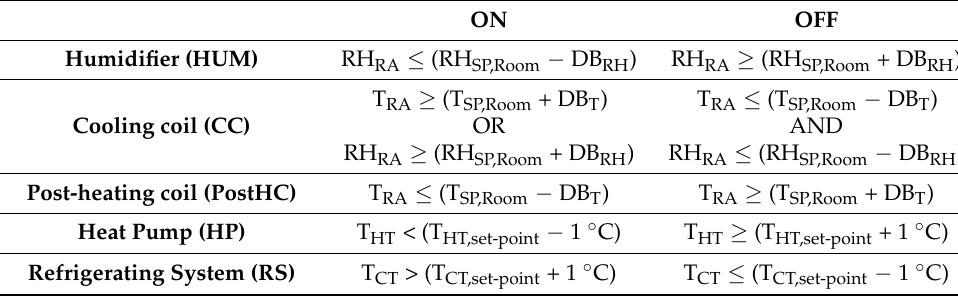
Table 4. Conditions for activating/deactivating the AHU components. ON OFF Humidifier